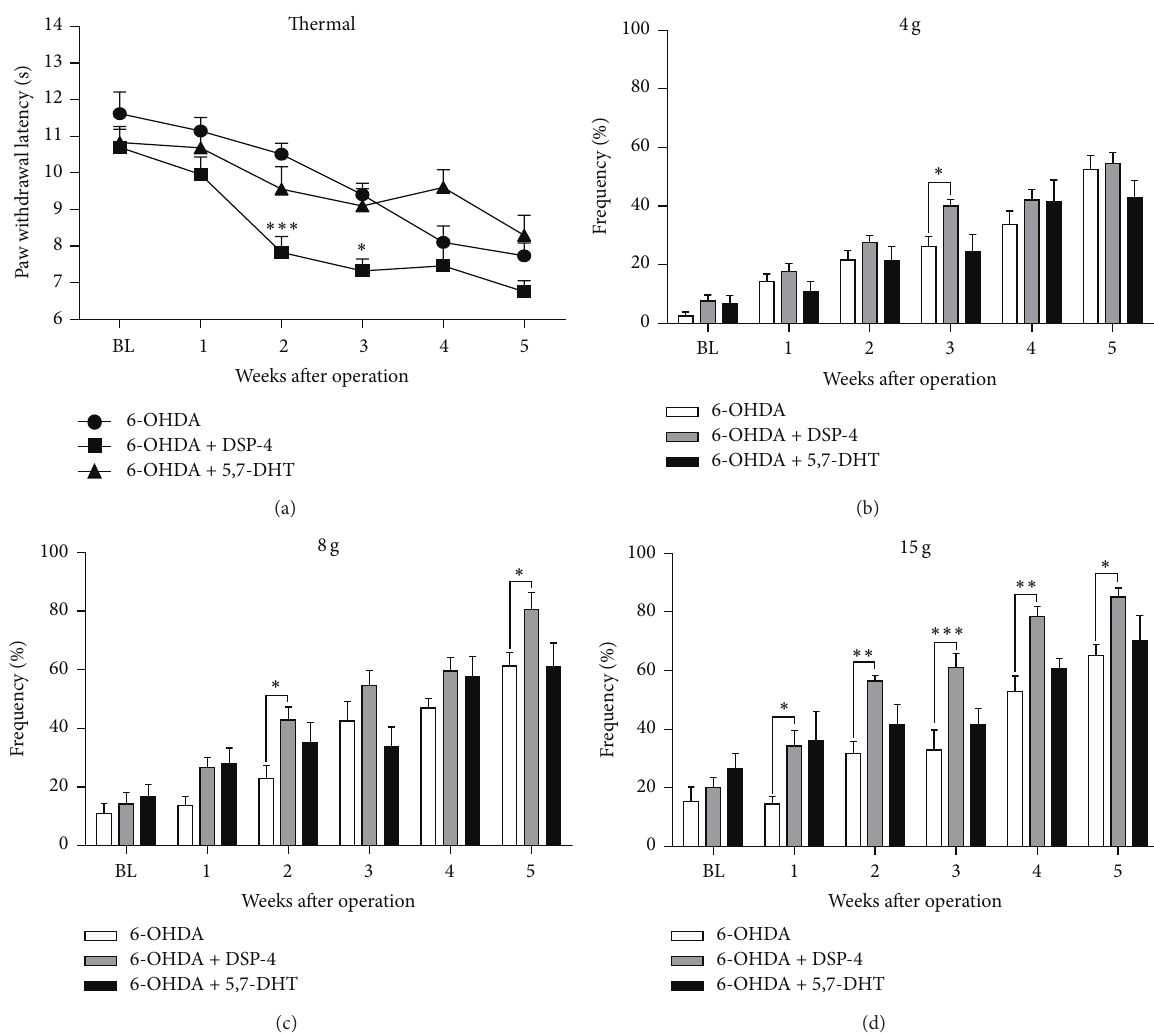
Figure 5: Effects of DSP-4 and 5,7-DHT on thermal and mechanical hypersensitivity in 6-OHDA-lesioned rats. (a) Compared to 6- OHDA-treated group, paw thermal withdrawal thresholds were decreased from the 2nd week after 6-OHDA plus DSP-4 injection. ((b)–(d)) Mechanical hypersensitivity was increased from the 2nd week after 6-OHDA plus DSP-4 injection and even increased from the 1st week after injection under 15g von Frey filament (d). However, compared to 6-OHDA-treated group, coinjection of 5,7-DHT and 6-OHDA simultaneous did not further increase the mechanical hypersensitivity in rats ( ∗ 𝑃 < 0.05 , ∗∗ 𝑃 < 0.01 , and ∗∗∗ 𝑃 < 0.001 compared to the sham control, 𝑛 = 6-7 for each group).